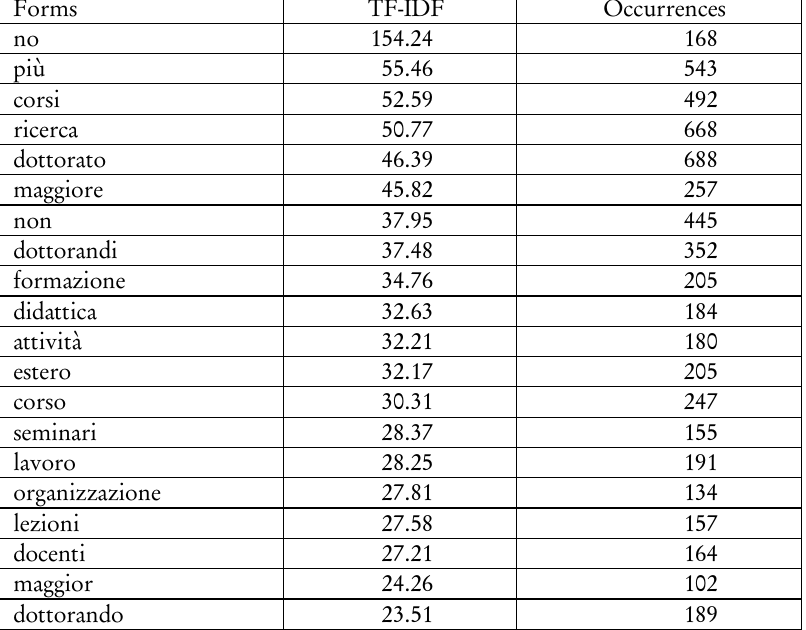
Main forms selected with the TF-IDF